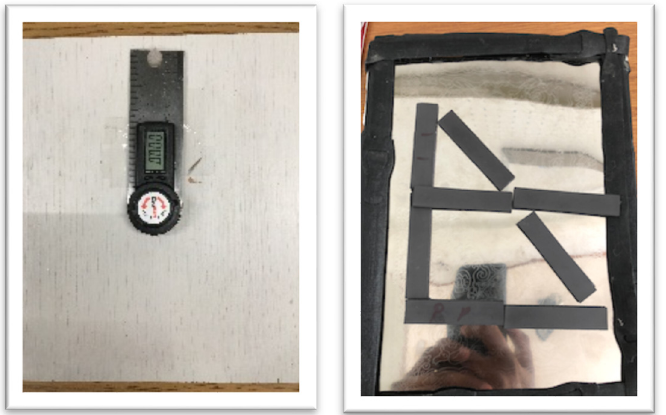
Figure 3. Pointing device used in the pointing task ( left ) and the stainless-steel canvas used for the reconstruction task with physical manipulatives ( right ).